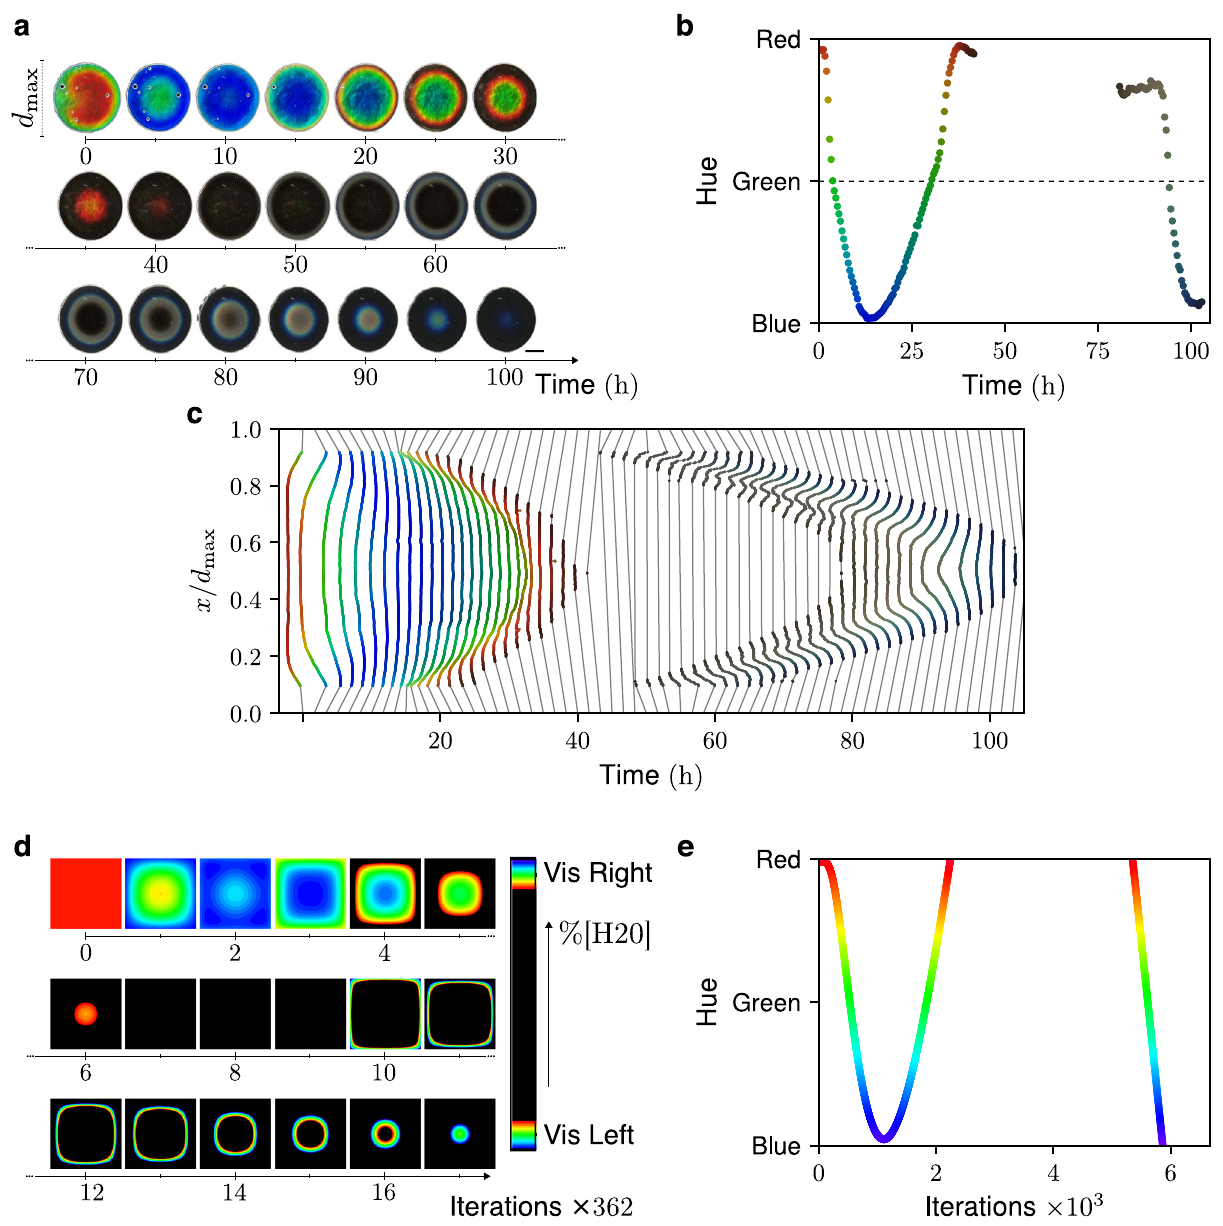
Fig. 3 Travelling cellulose-structural colours in a quasi-2D geometry. a Example of a quasi-2D liquid crystalline sample evolution (prepared from a droplet con fi ned between two fl at glass slides) (see Supplementary Movie 2), showing the variation of the bright colours exhibited by the L cholesteric structure, time lower than 40 h, and the presence of the faint colours of the R cholesteric structure, time after 50 h. Scale bar 2 mm. b Evolution of the colours at the centre of the sample, showing the reappearance of the bright initial colours and the appearance of the faint colours, after 50 h. c Same as in b but along a line that passes through the centre of the sample with maximum length equal to d max (shown in a ). d Numerical simulations of travelling colours with square geometry (see Supplementary Movie 2) showing similar behaviour to the example shown in a . Colour map is based on the relative density of water, r, with two red-green-blue regions, matching visible light response from L and R structures, and black regions for non-visible light responses. e Evolution of the colours at the centre of the simulated presence of water shifts the maximum wavelength re fl ection of To emphasize and distinguish the behaviour of the quasi-2D the samples to higher values (Supplementary Movie 3) and the sample at the border and at the centre the evolution of the colours sequence of right (R) colours (at the border) appears faster when was investigated along a line passing through the centre of the compared with the 2D sample prepared with no water addition. sample, as shown in Fig. 3c. These results provide clear evidence of To test the in fl uence of TFA, on the right (R) and left (L) the oscillatory regime for the appearance, shrinkage and disappear- oscillations, TFA was added at the periphery of a 2D preparation ance of the coloured rings. The shape of the plot line changes after that already presented an R sequence of colours at the centre, the fi rst 10 h (change of curvature), which coincides with the (Supplementary Fig. 5 and Supplementary Movie 4). A new reappearance of a new green ring at the periphery. Then, the sequence of L colours reappears, at the border, where the TFA curvature of the line continues to change until, after about 80 h, a was added. similar shape to the one exhibited at the beginning is recovered.